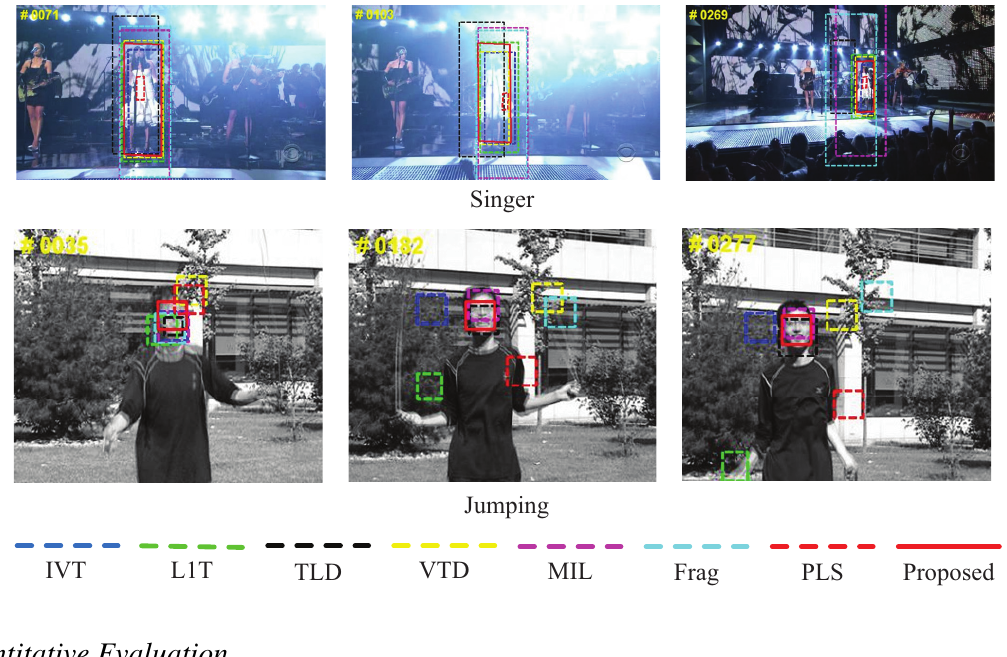
Figure 8. Qualitative evaluation results of eight algorithms on challenging tested sequences Singer and Jumping